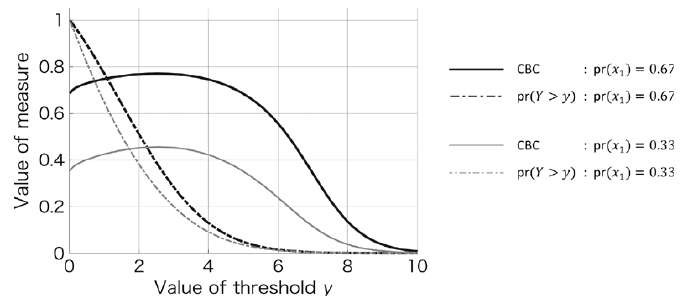
Figure 2: Comparison between the CBC and pr ( Y > y ) (1).